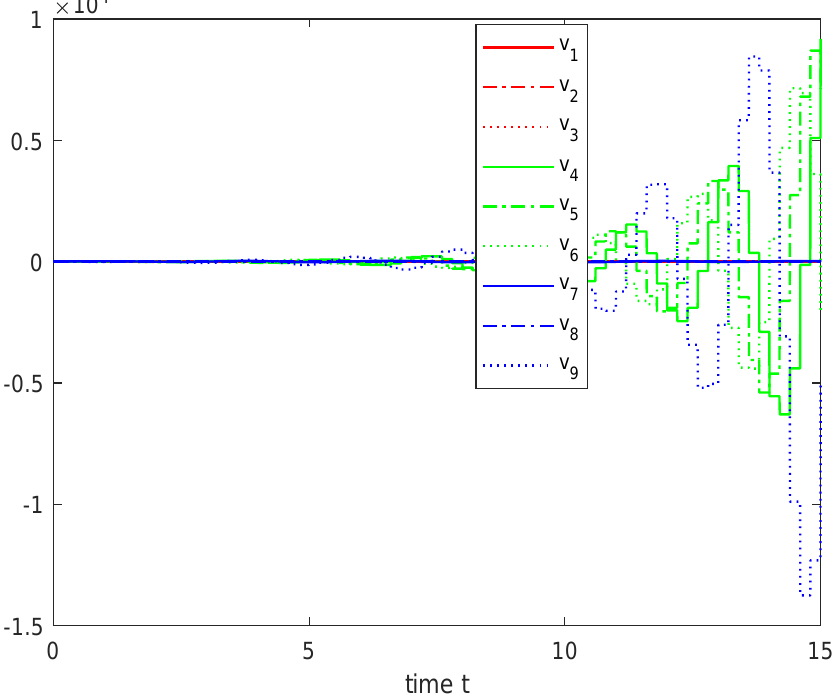
Figure 5. The time evolution trajectories of v i ( t ) , i = 1,2, · · · ,9, with h = 0.2 in Example